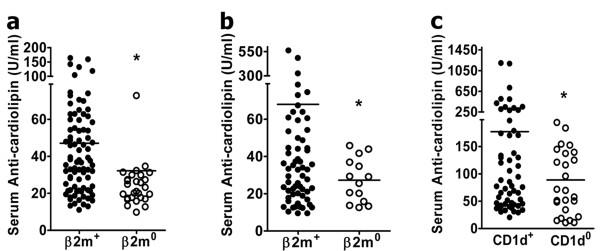
Serum anti-cardiolipin (anti-CL) antibodies are decreased in β2 microglobulin-deficient (β2m°) and CD1d-deficient (CD1d°) BWF1 mice. (a-c) β2m° or CD1d° BWF1 mice and control littermates (β2m+/+ or β2m+/-, designated as β2m+; and CD1d+/+ or CD1d+/-, designated as CD1d+) were bled and serum samples tested for serum immunoglobulin G (IgG) anti-CL antibodies: (a) 4-month-old β2m+ (n = 88) and β2m° (n = 32); (b) 6- to 8-month-old β2m+ (n = 75) and β2m° (n = 14); (c) 7- to 8-month-old CD1d+ (n = 57) and CD1d° (n = 26) mice. Each symbol represents a single mouse, and horizontal bars represent the mean U/ml for the group. The negative control mean ± SD values for anti-CL antibody in six normal BALB/c mice was 15.1 ± 5.2 U/ml. *P <0.01, Student's t-test.